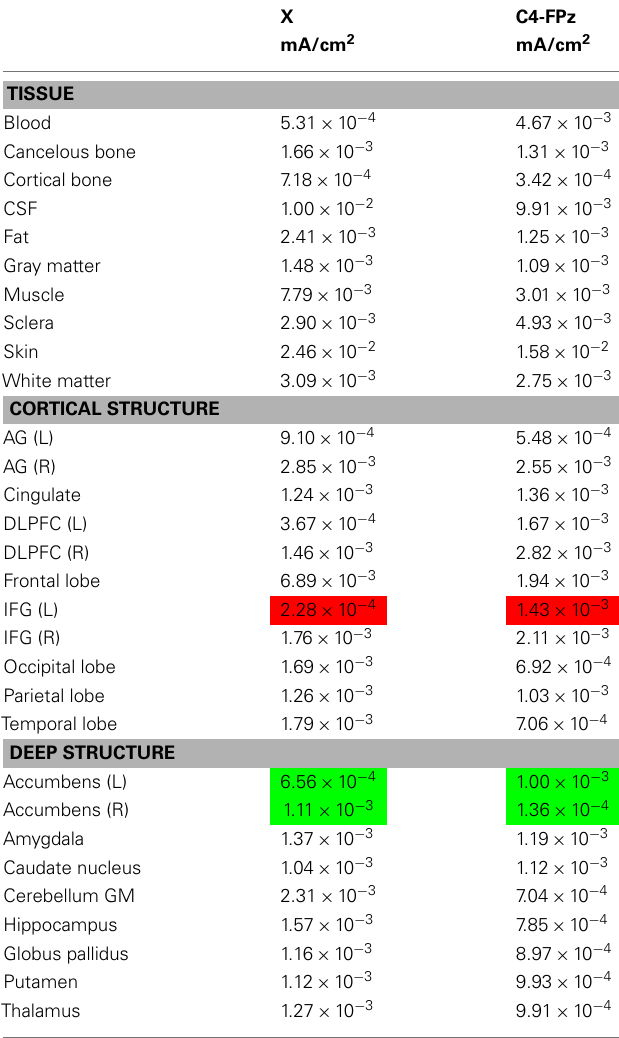
Table 4 | Median current density values found in different tissues and structures for Problem 3.